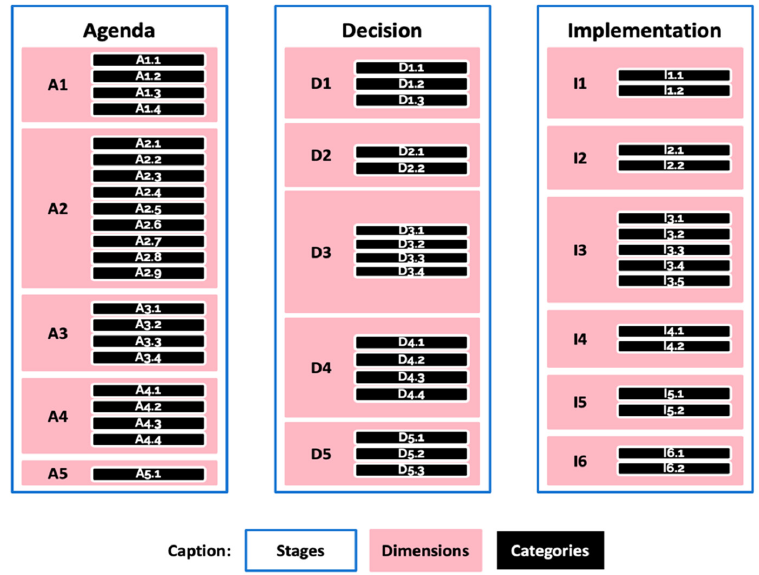
Figure 2. Skeleton of the Theoretical Framework adopted. Source: the authors.